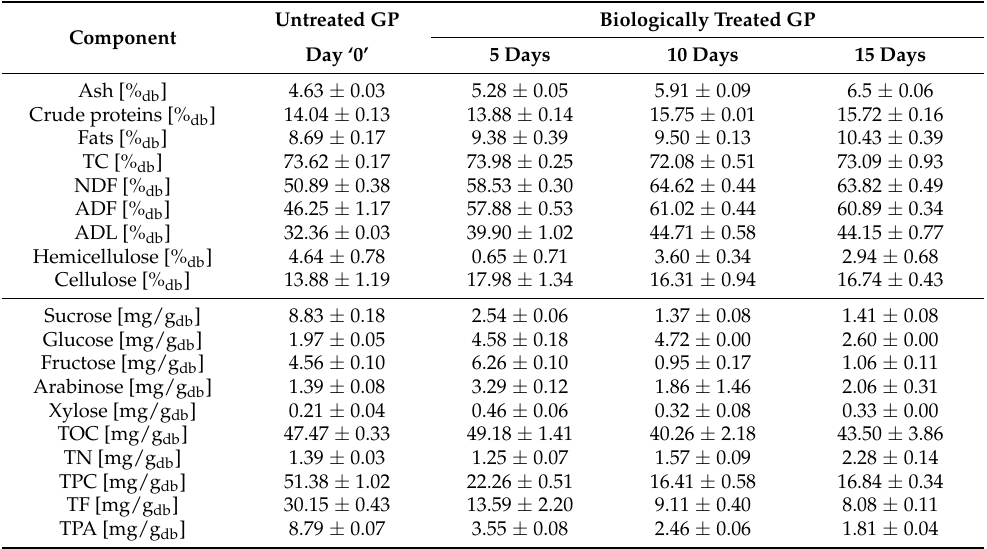
Table 1. Chemical composition of the grape pomace (GP) before (day ‘0’) and after solid-state fermentation (SSF) (5–15 days) with